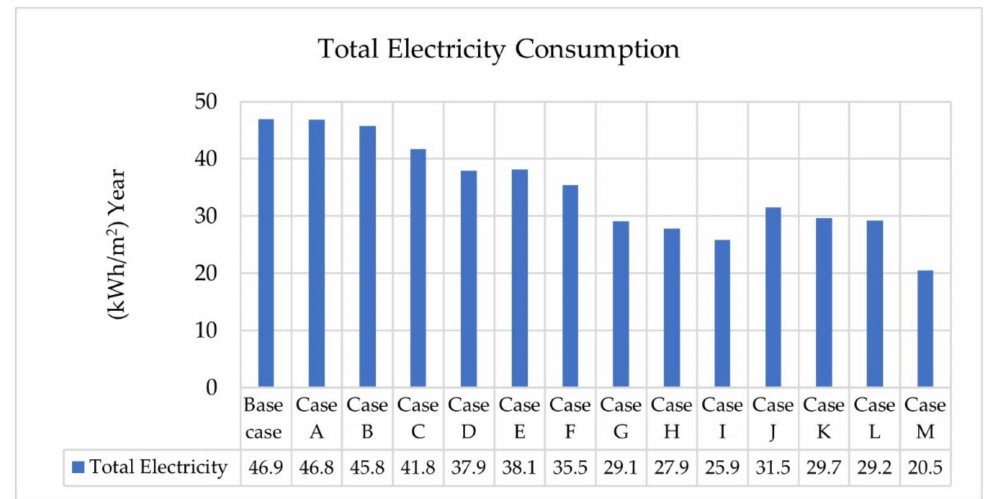
Figure A6. A comparison between the electricity consumption of the base case and the proposed scenarios.